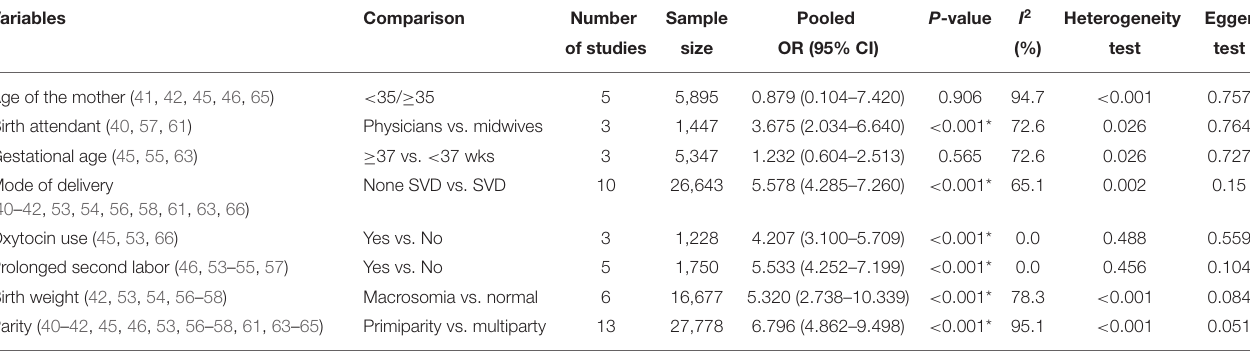
TABLE 5 | Factors associated with episiotomy practice in Africa,